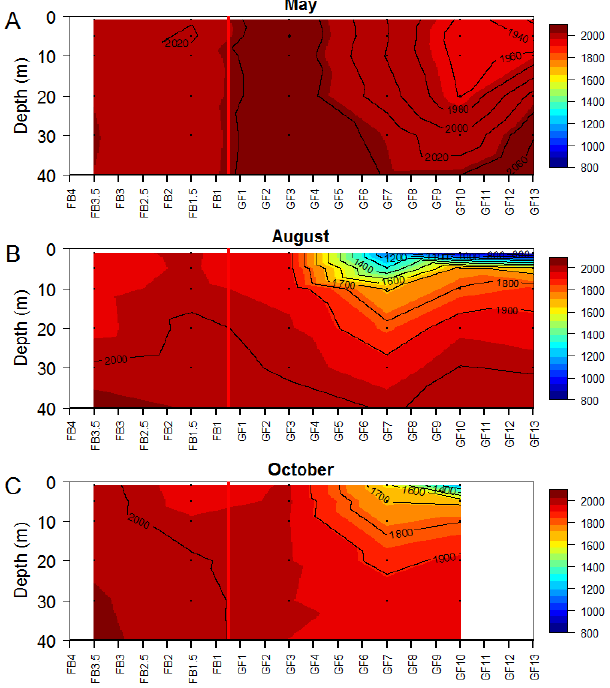
Figure 6. Dissolved inorganic carbon (DIC in µmolkg − 1 ) data for May (a) , August (b) and October (c) 2013 along a transect from the shelf (left) to the glaciers (right). The red line indicates the mouth of the Godthåbsfjord